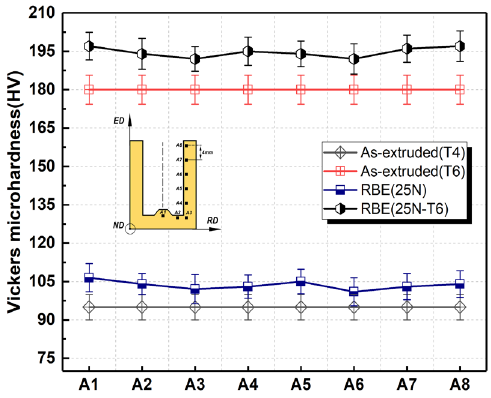
Figure 18. Vickers microhardness of T6-extruded bar, T4-extruded bar, RBE (25 N), and T6-RBE (25 N) samples.